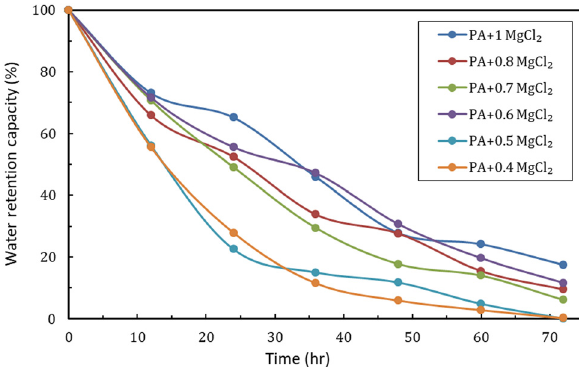
Figure 11: Water retention capacity ( % ) of KPA SAPs at various immersion times.